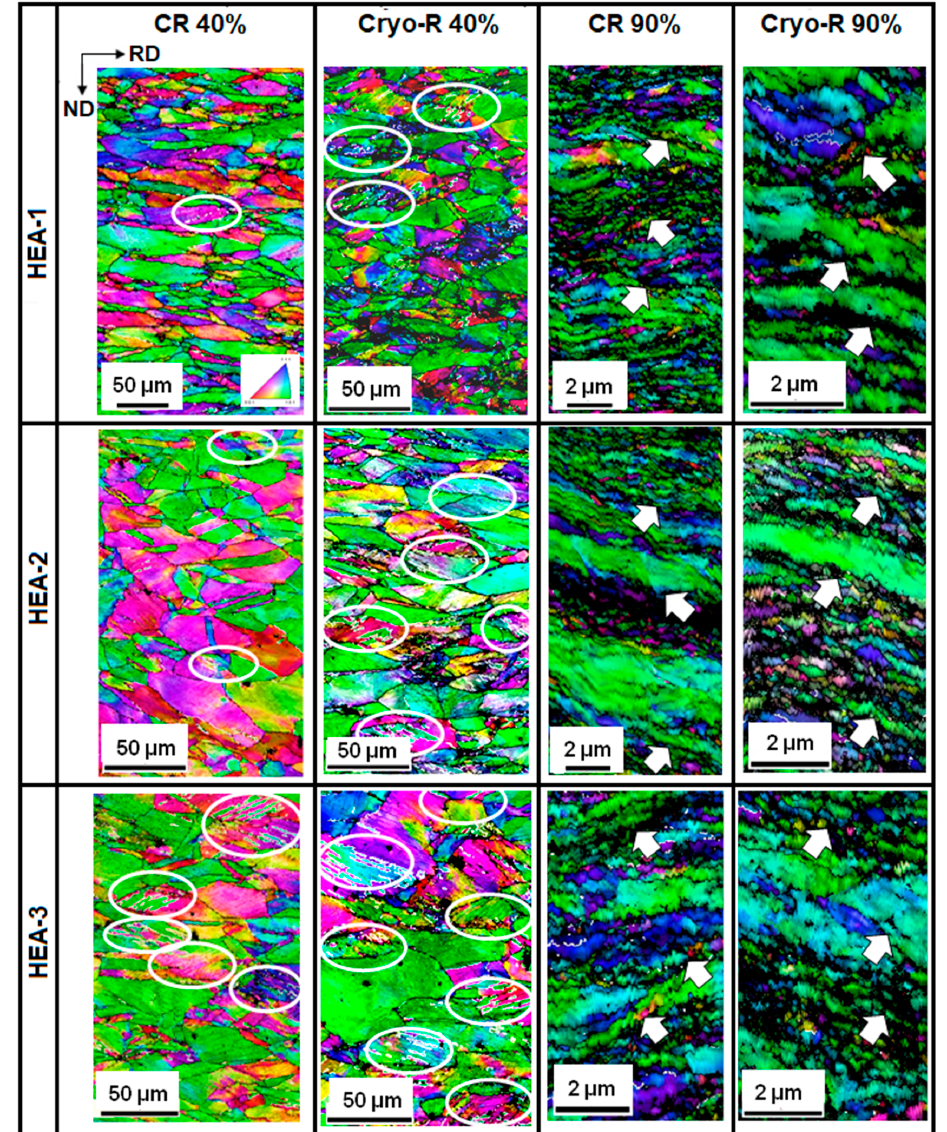
Figure 3. Microstructure of cold-rolled (CR) and cryo-rolled (Cryo-R) HEAs 1–3 represented by IPF maps (black lines: high angle grain boundaries; white lines: Σ 3 twin boundaries (bundles marked by ellipses); fine-scale shear bands marked by arrows; color coding of the normal direction).